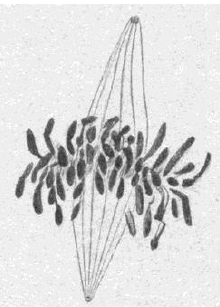
Figure 4. Drawing of a mitotic figure in a live cell prepared by Mayzel and published by Flemming,